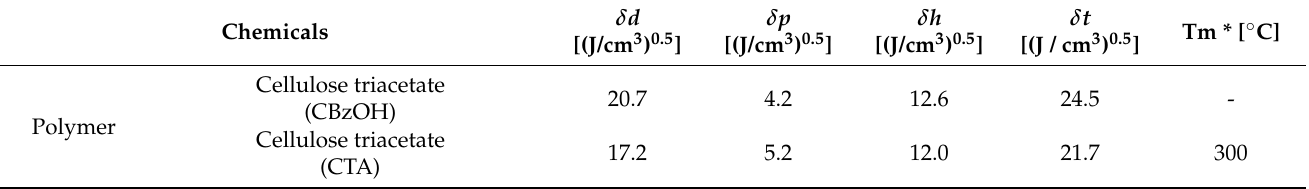
Table A1. Hansen solubility parameter (HSP) [27] and melting temperature of cellulose derivatives polymers and solvents used in the solvent